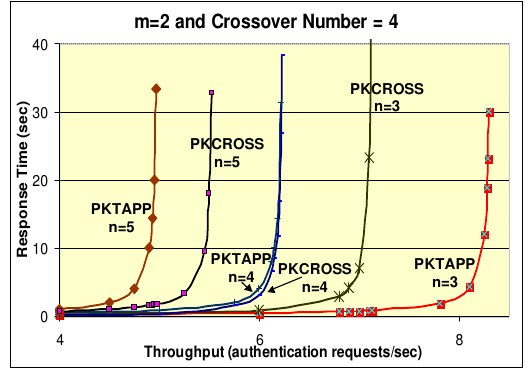
Figure 6. Response Time vs. Authentication Request Rate y = 1.8916x + 0.2879